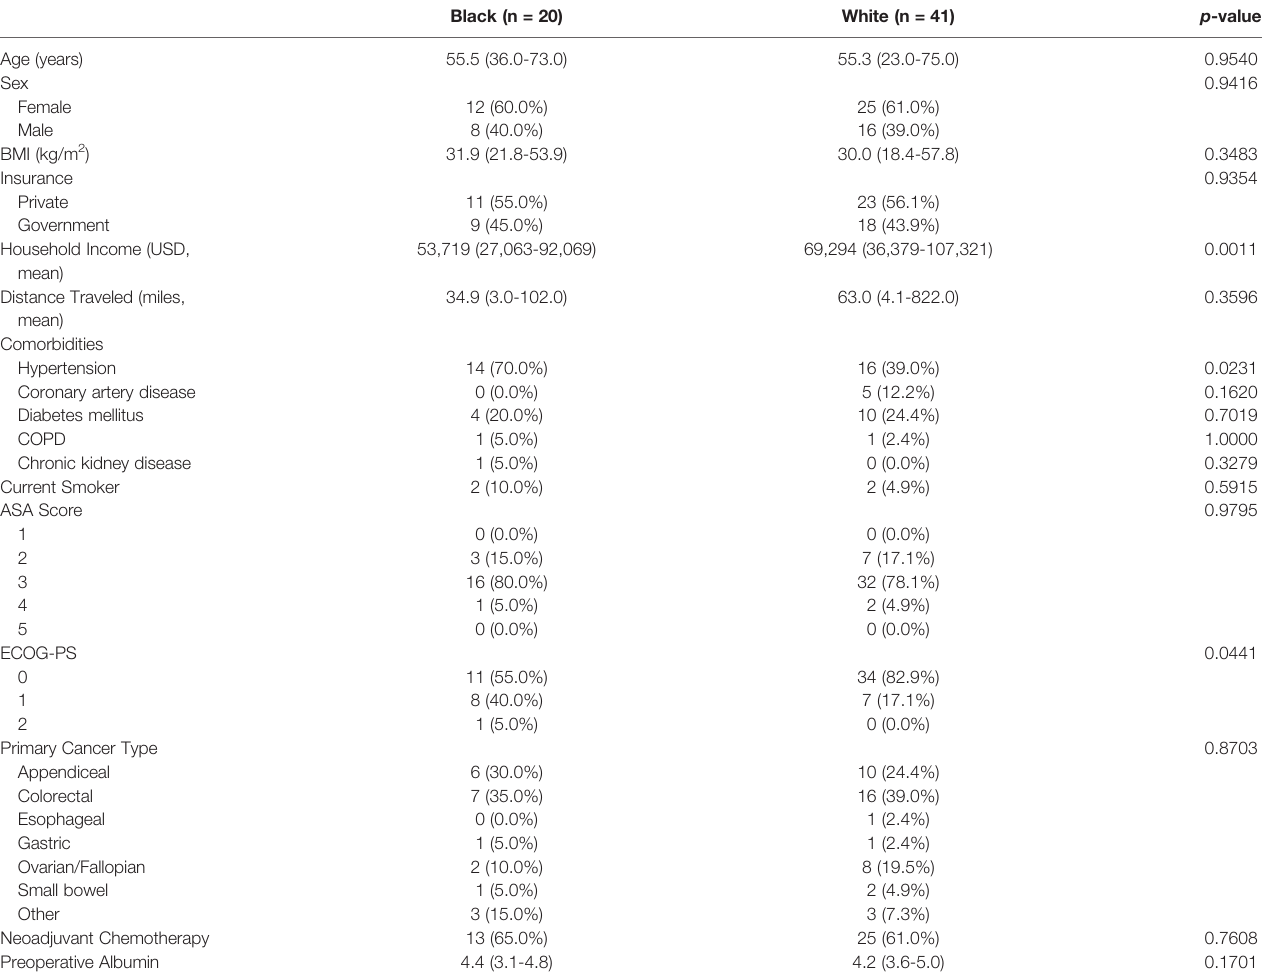
TABLE 1 | Patient demographics and preoperative demographics by